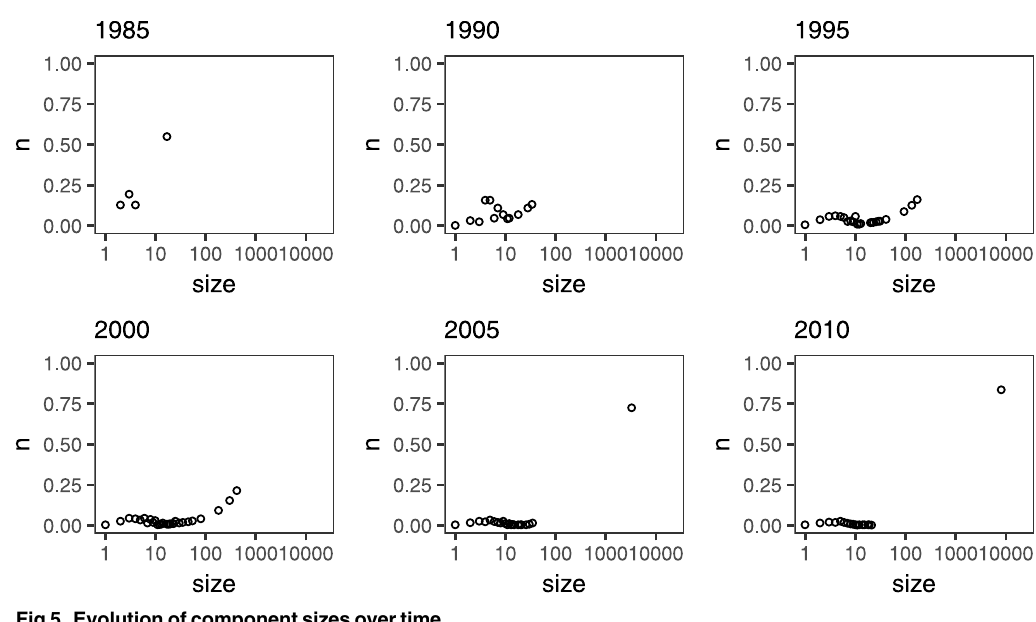
Fig 5. Evolution of component sizes over time.